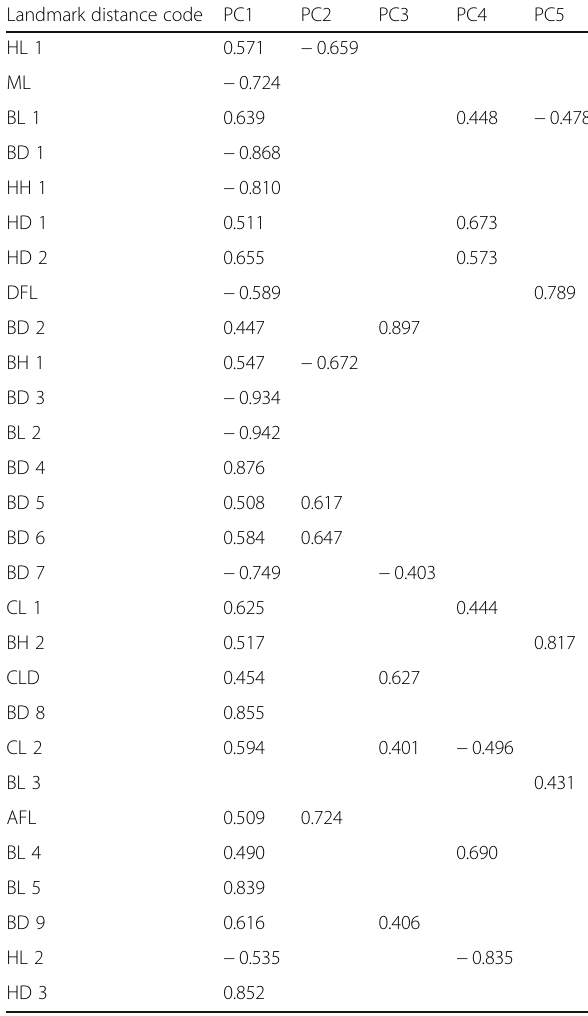
Table 6 Results of factors extraction in PC analysis after varimax normalized rotation in A. clupeoides from the Bay of Bengal coast, Bangladesh Landmark distance code